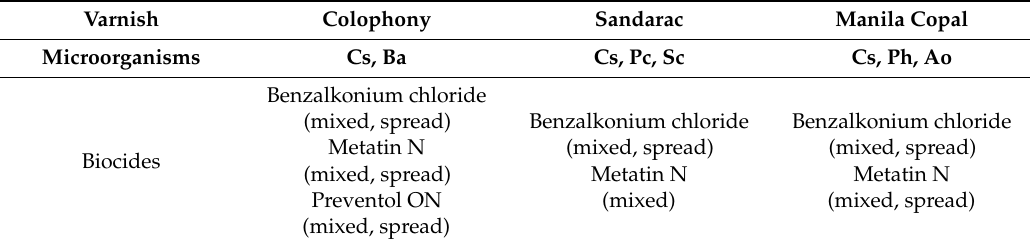
Table 1. Samples included in the